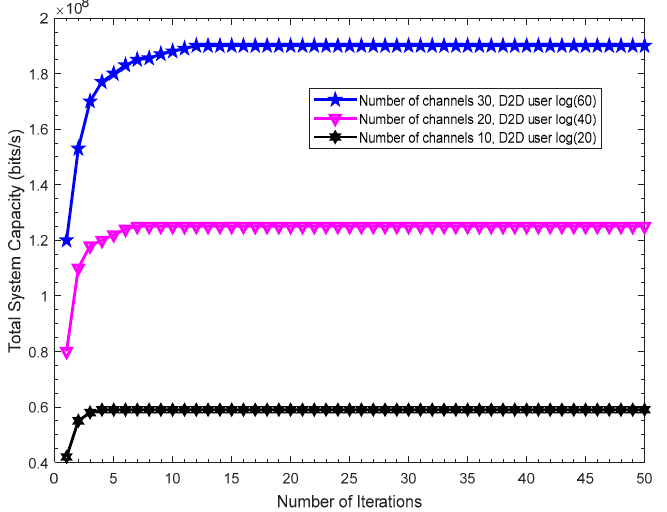
Figure 6. The convergence of the proposed algorithm.